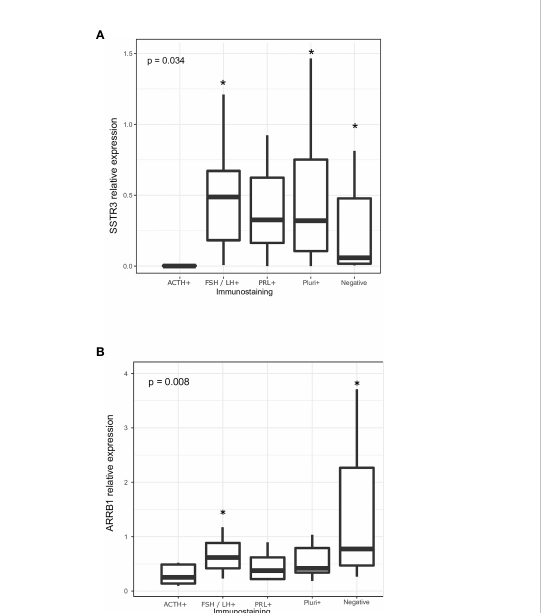
FIGURE 5 (A) Relative expression of SSTR3 according to the immunohistochemical expression of the pituitary hormones. (B) Relative expression of ARRB1 according to the immunohistochemical expression of the pituitary hormones. P-values for the different group comparisons regarding SSTR3 expression: ACTH+ vs. FSH/LH-+ (p=0.001), ACTH+ vs. PRL+ (p=0.418), ACTH+ vs. plurihormonal NF-PitNETs (p=0.005), ACTH+ vs. negative tumors (p=0.004), FSH/LH+ vs. PRL+ (p=0.418), FSH/LH+ vs. plurihormonal NF-PitNETs (p=0.429), FSH/LH+ vs. negative tumors (p=0.603), PRL+ vs. plurihormonal NF-PitNETs (p=1), PRL+ vs. negative tumors (p=0.795) and plurihormonal NF-PitNETs vs. negative tumors (p=0.787). P-values for the different group comparisons regarding ARRB1 expression: ACTH+ vs. FSH/LH-+ (p=0.005), ACTH+ vs. PRL+ (p=0.509), ACTH+ vs. plurihormonal NF-PitNETs (p=0.152), ACTH+ vs. negative tumors (p=0.012), FSH/LH+ vs. PRL+ (p=0.119), FSH/LH+ vs. plurihormonal NF-PitNETs (p=0.085), FSH/LH+ vs. negative tumors (p=0.147), PRL+ vs. plurihormonal NF-PitNETs (p=0.535), PRL+ vs. negative tumors (p=0.051) and plurihormonal NF-PitNETs vs. negative tumors (p=0.026). * indicates the subtypes of NF-PitNETs that showed signi fi cant differences compared to ACTH+